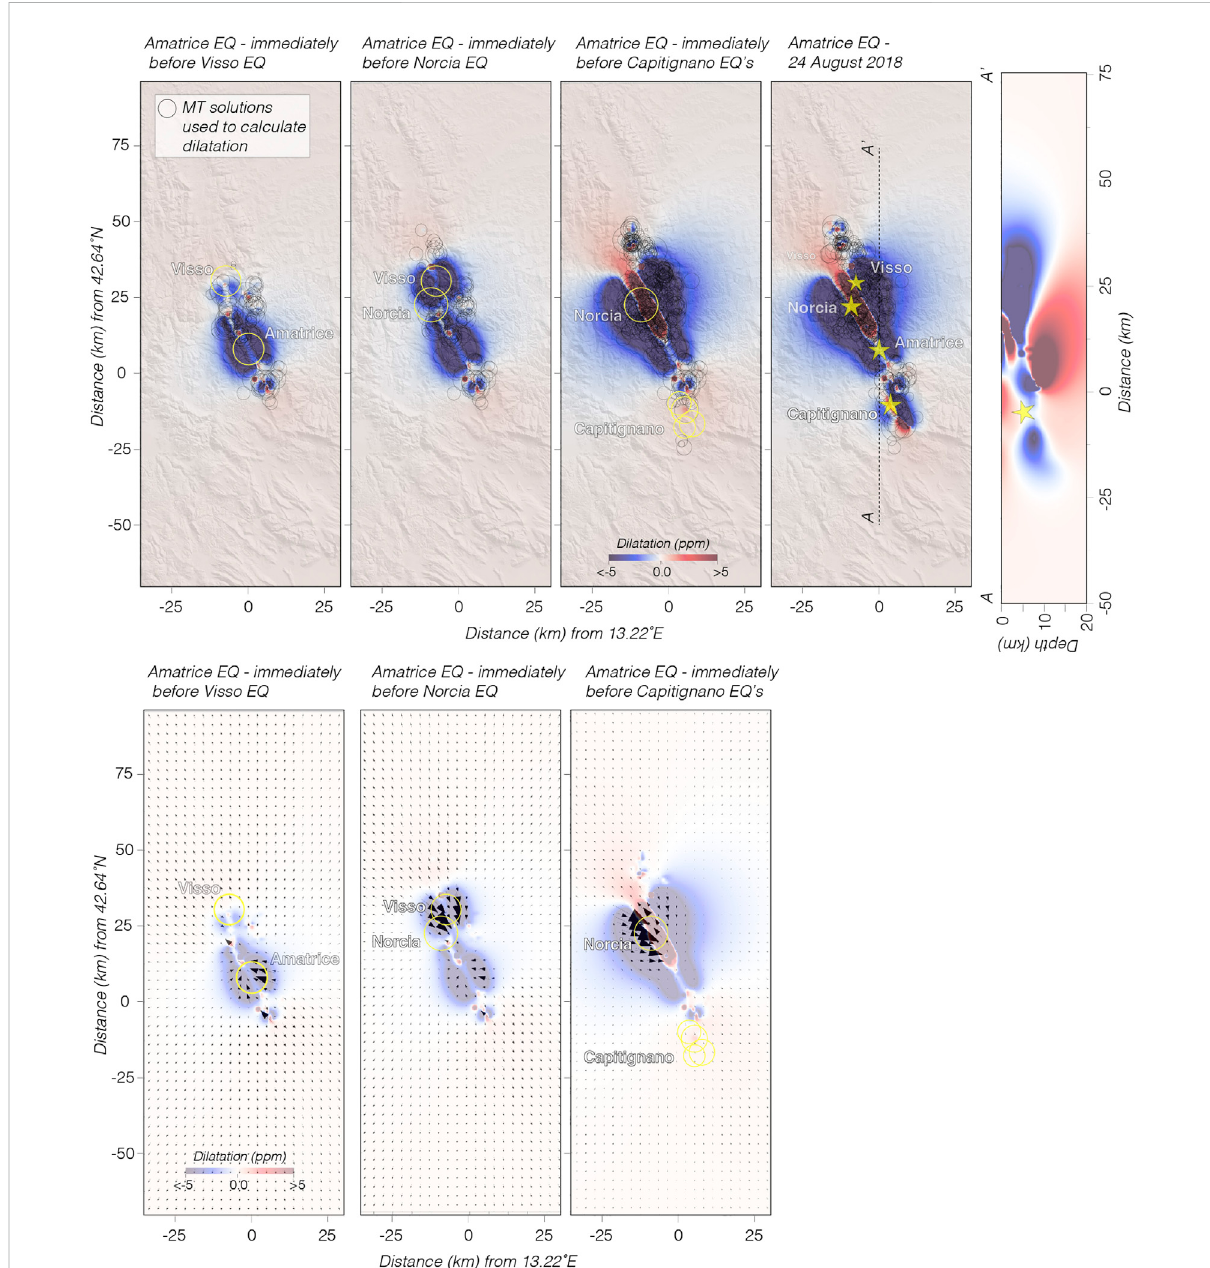
FIGURE 6 Upper Cumulative dilatation. Cumulative dilatation is calculated assuming the SW dipping moment tensor solutions of M ≥ 3 earthquakes were theruptureplanes.Dilatationisshownonhorizontalplanesat5 kmdepth,andacrosssectionisalsoshown.Ifdropsin Q − 1 S ( f , t ) arerelatedtodropsin crack density, negative dilatation (compression) is to be expected, in close agreement with the conceptual model by Muir-Wood and King (1993). Lower Expected relative fl ow magnitudes and directions resulting from coseismic dilatation changes caused by M ≥ 3 earthquakes beginning with the 24 August 2016 Amatrice earthquake to times just before the Visso, Norcia, and Capitignano